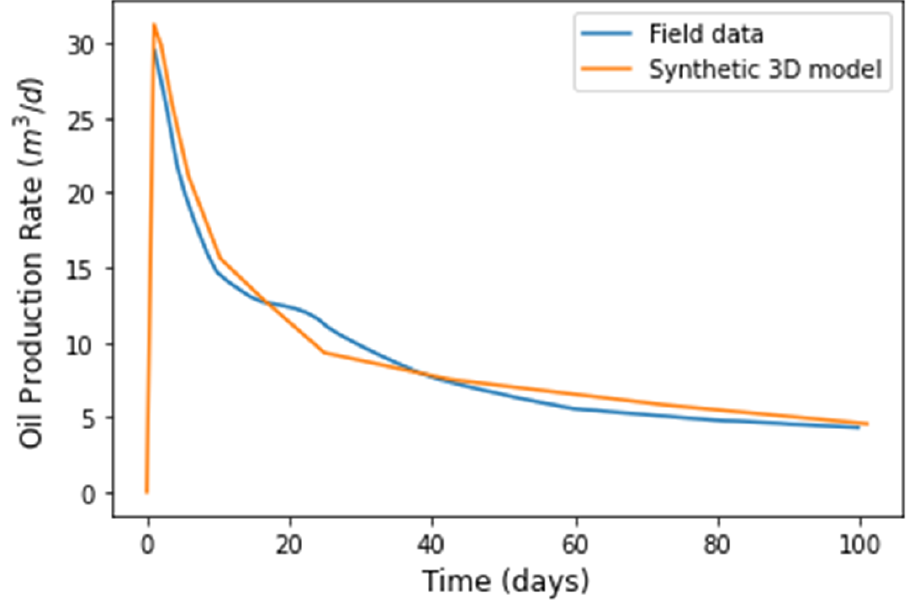
Figure 3. Validation of the synthetic 3D reservoir model to the field data [46].